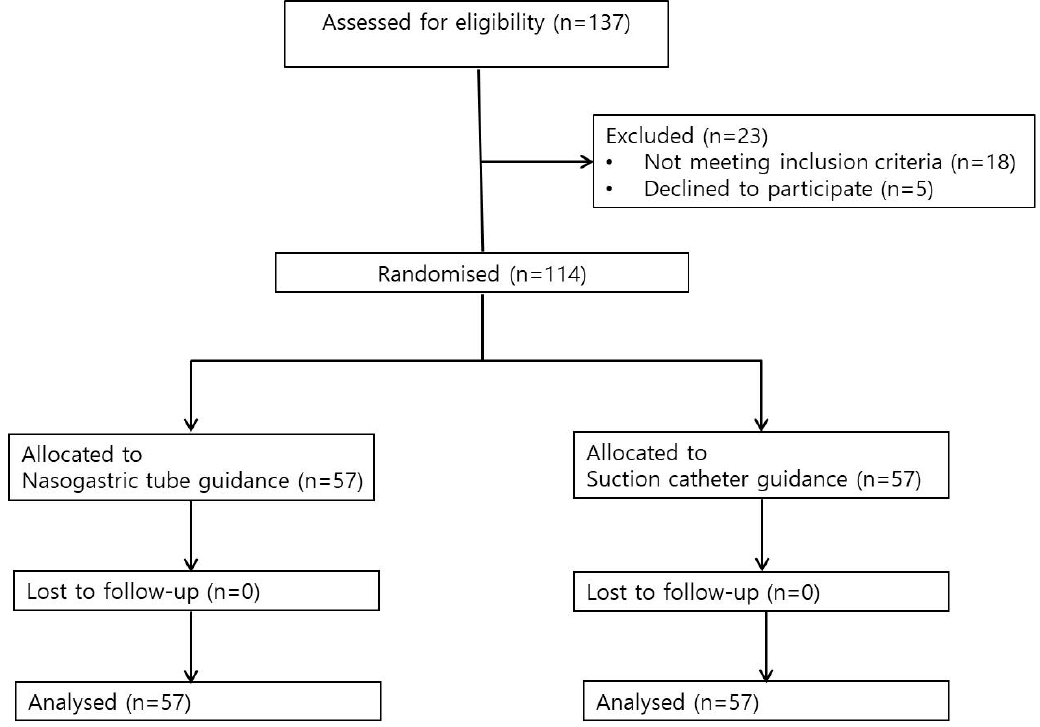
Figure 2. Study flow diagram. When the nasotracheal tube was passing through the nose, the number of preformed nasotracheal tube manipulations, navigability, and tube rotation did not differ significantly between the two groups. Regarding the passage of the nasotracheal tube through the nasal Table 1. Patient demographics, pre-operative airway examinations, and intubation variables. cavity into the pharynx, there were no differences between the two groups in the degree of nasal bleeding through direct laryngoscopy, the use of Magill forceps, or the total number